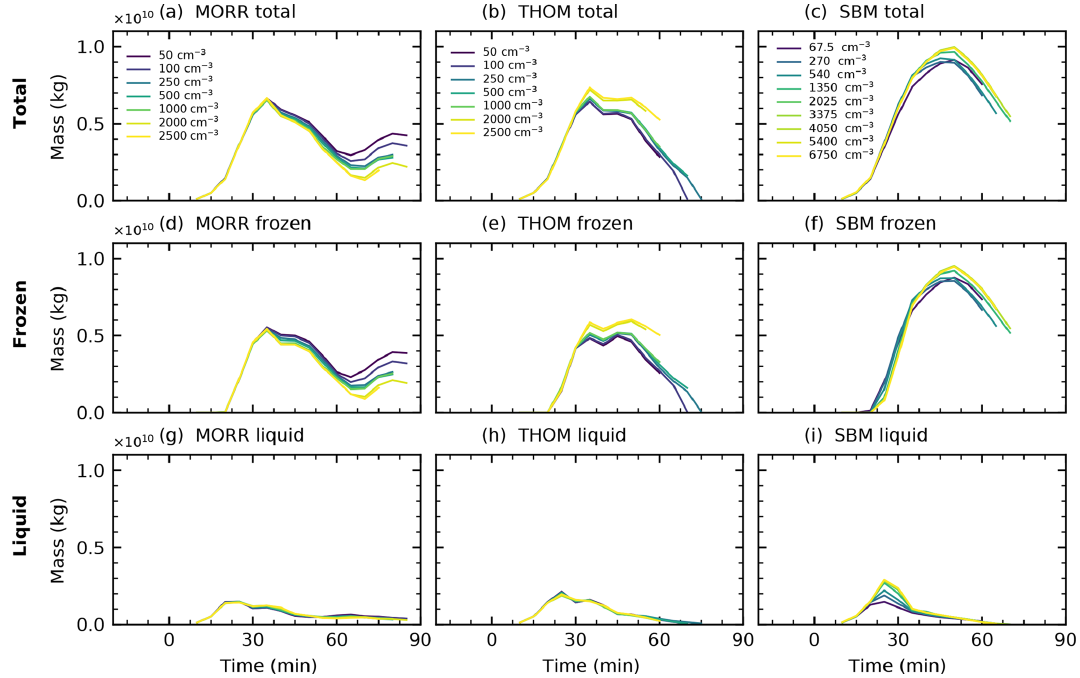
Figure 15. Total water mass, liquid water mass and frozen water mass in the analysed left-moving cell for the three different microphysics schemes (Morrison: a , d , g , Thompson: b , e , h , SBM: c , f , i ) in